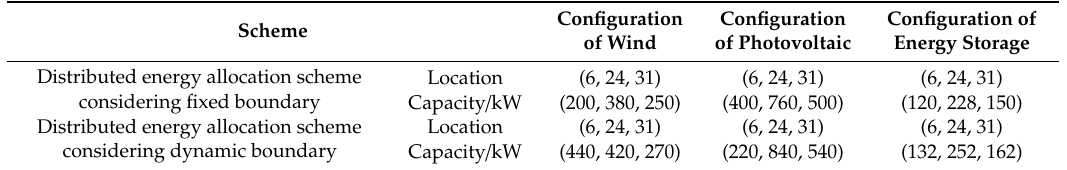
Table 3. Configuration scheme of the distributed energy considering the fixed boundary and dynamic boundary.